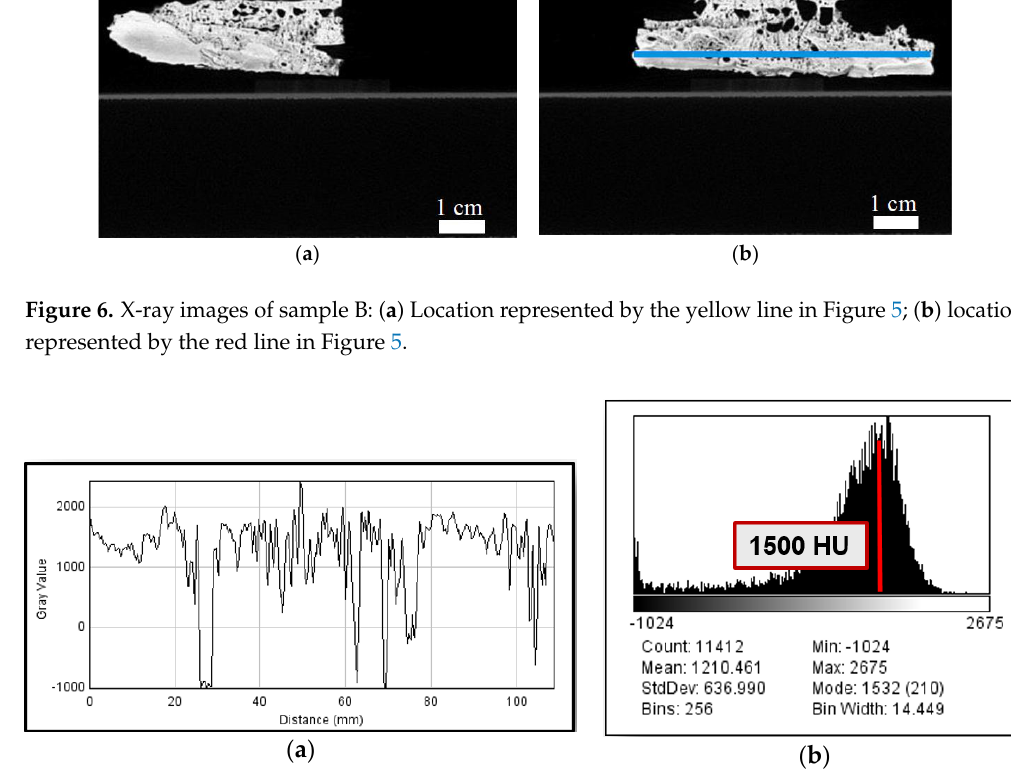
Figure 7. X-ray absorption coefficient (HU) distribution ( a ) and histogram ( b ) at the middle height of Figure 6b (blue line).